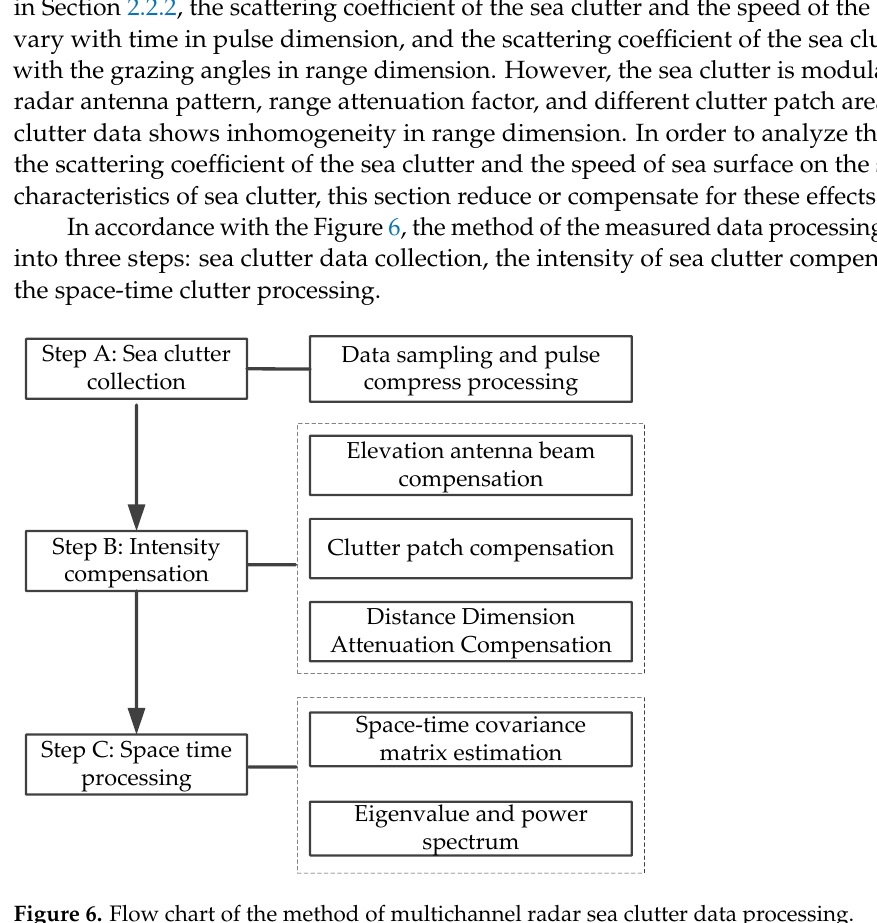
Figure 6. Flow chart of the method of multichannel radar sea clutter data processing. Step A: sea clutter data collection.